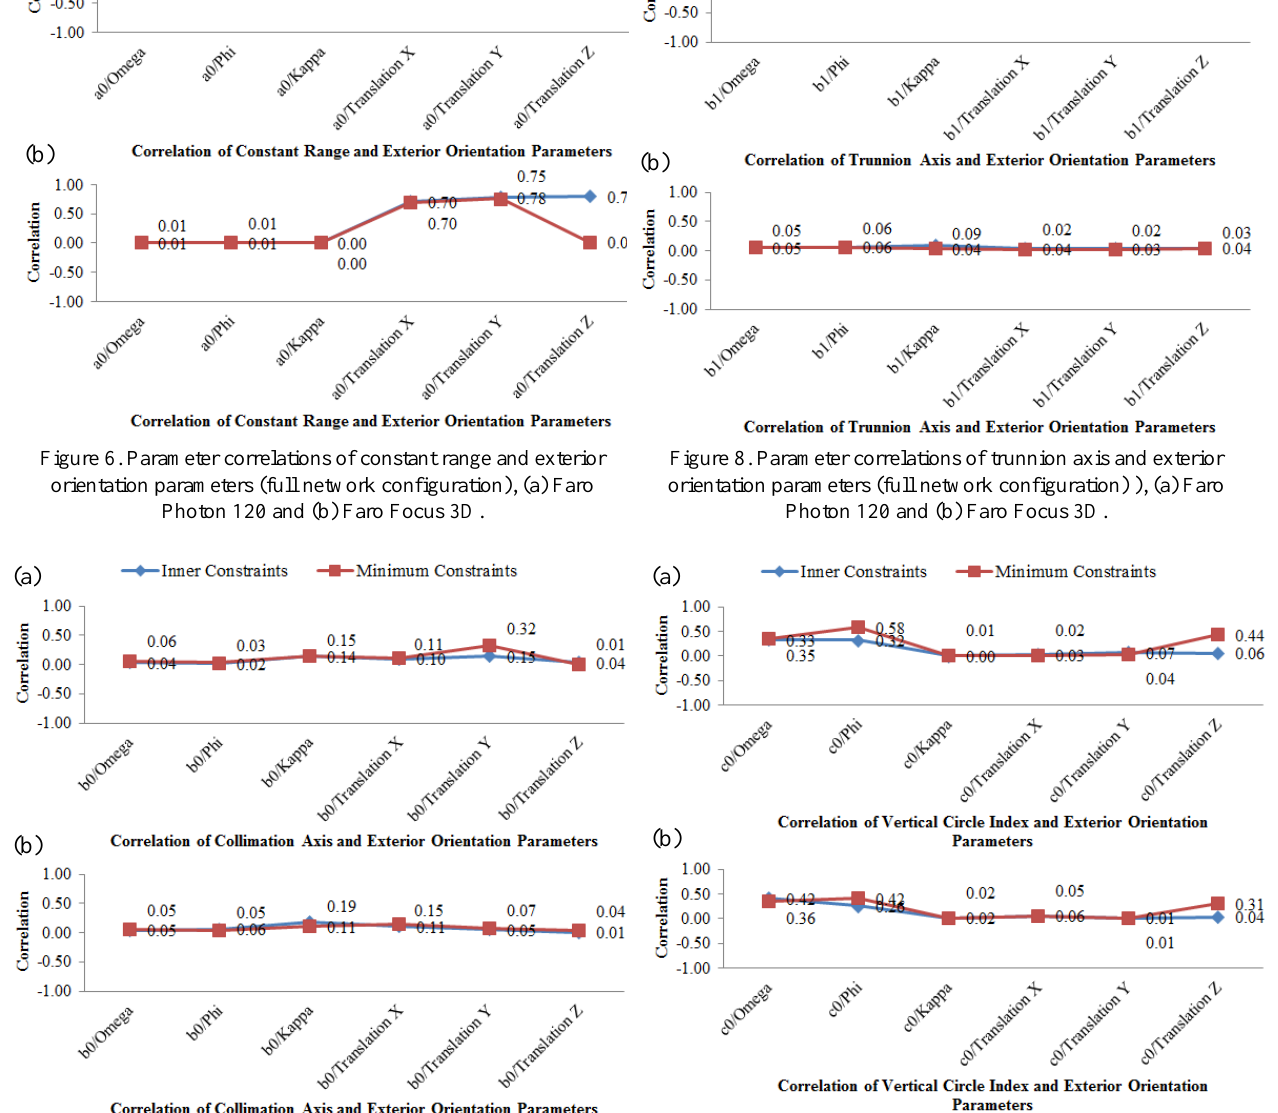
Figure 7. Parameter correlations of collimation axis and exterior orientation parameters (full network configuration) ), (a) Faro Photon 120 and (b) Faro Focus 3D.